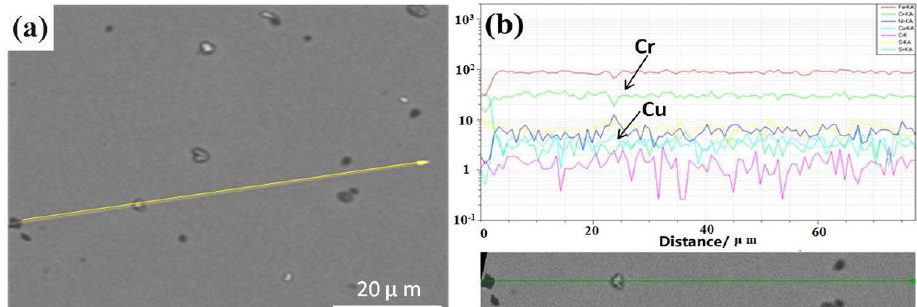
Figure 6. SEM-EDS elemental line-scan map during hot deformation with the strain of 0.2 at 1050 °C. ( a ) line-scan map, ( b ) line-scan EDS.